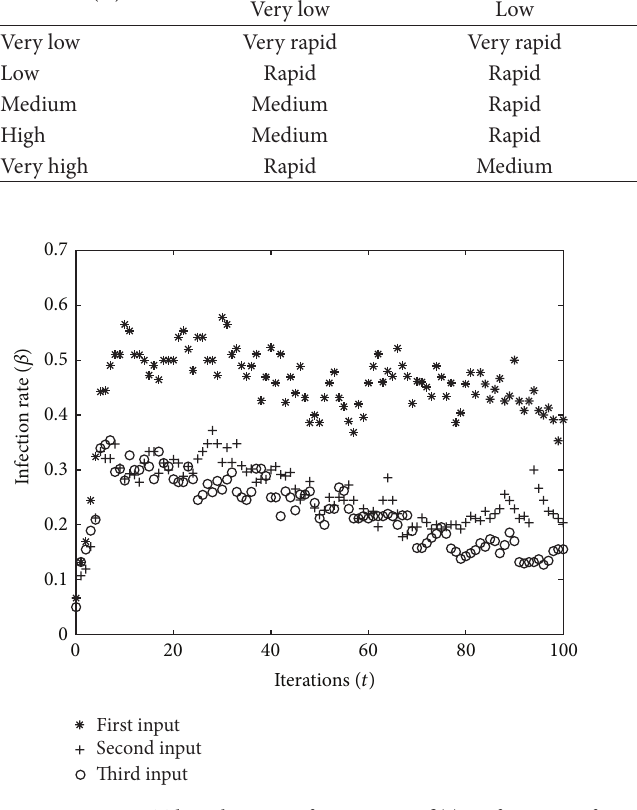
Figure 3: CD4 + T lymphocyte infection rates 𝛽(𝑡) in function of time obtained with the cellular automaton for the three inputs.